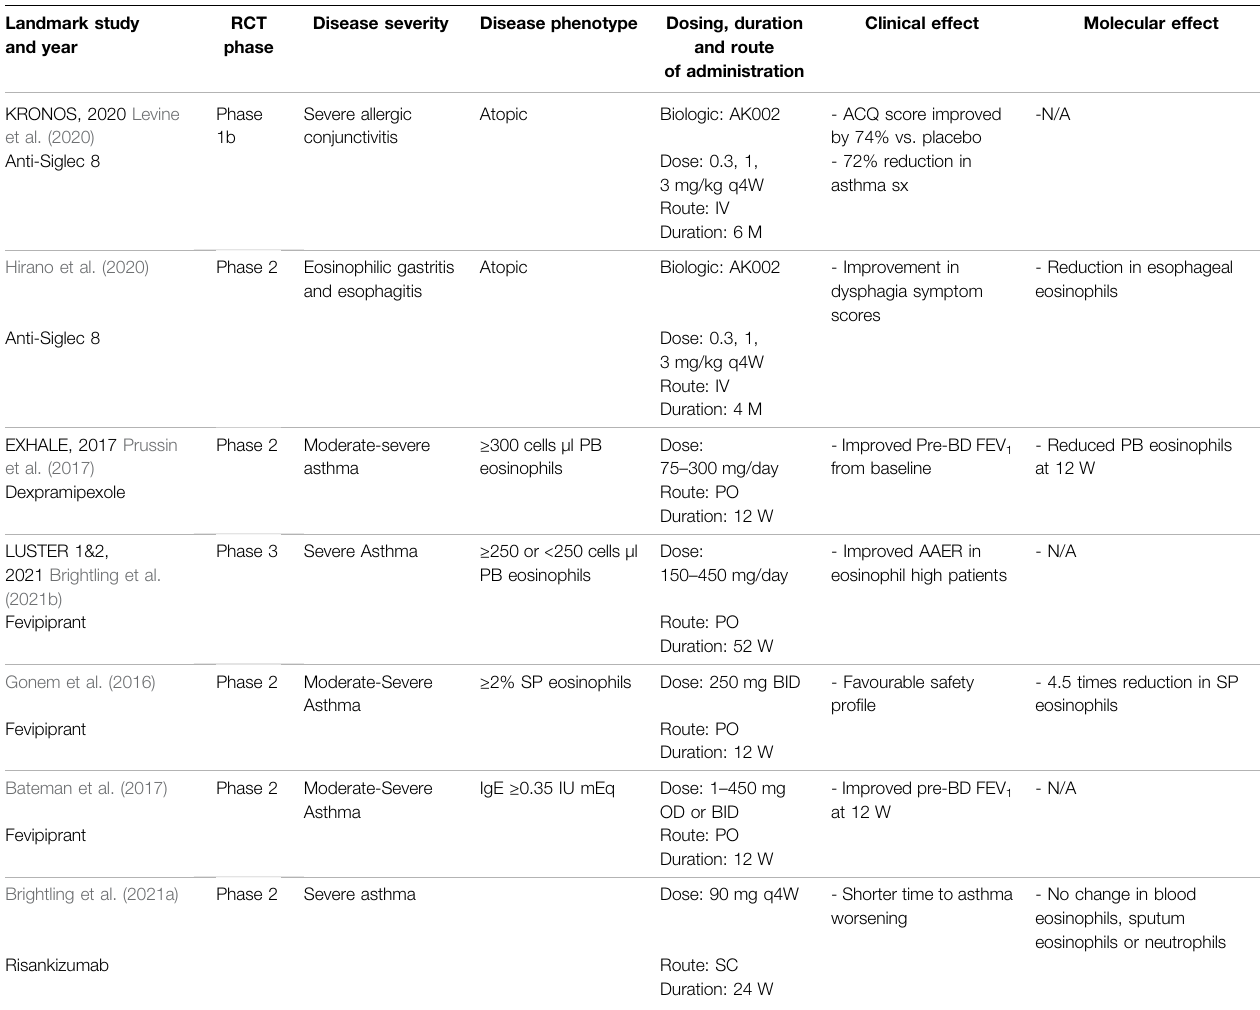
TABLE 8 | Summary of other therapeutic targets in severe